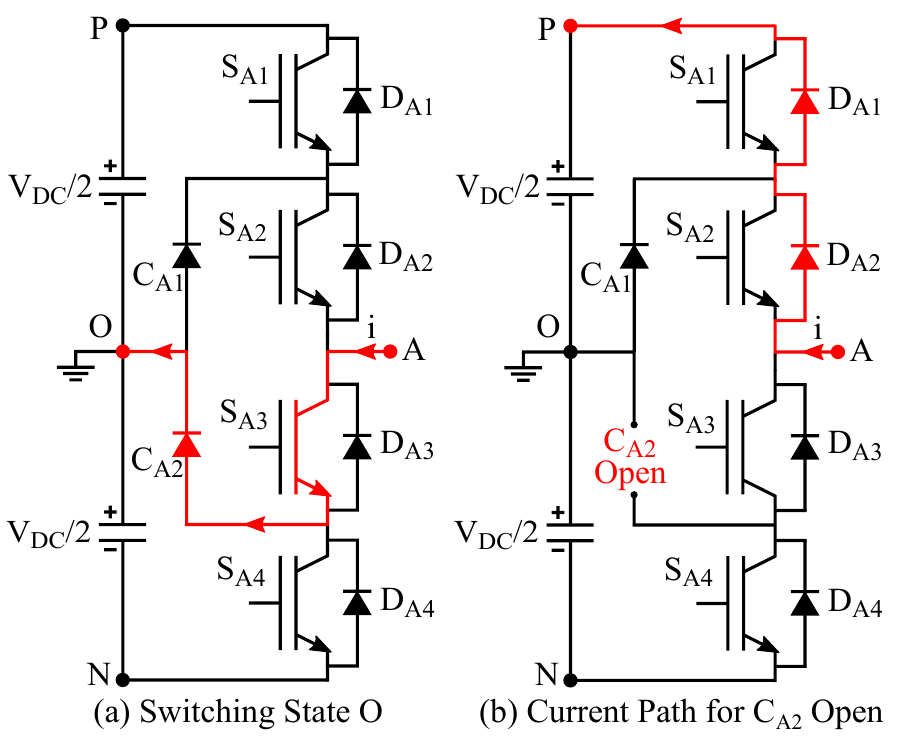
Figure 9. C A 2 OC switch fault. Table 2. Pole voltage deviation under faulty